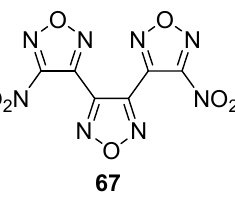
Figure 6. Molecular structure of LLM-172 (67). Table 10. Performance and sensitivities of LLM-172 (67).